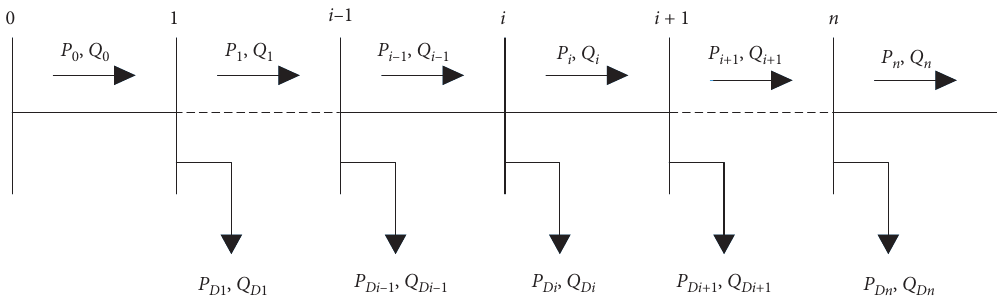
Figure 1: Representation of a single-line radial